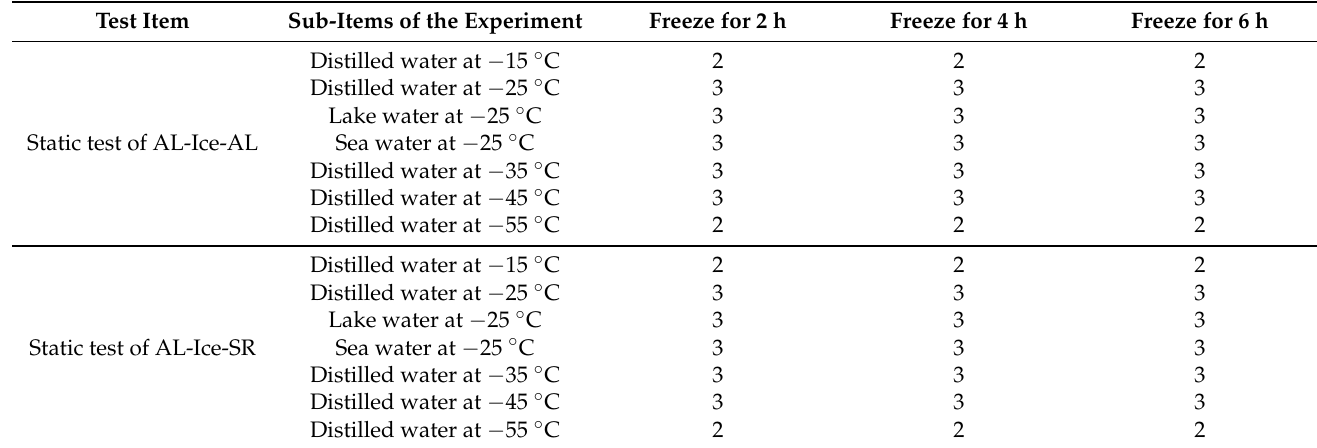
Table 3. Test the subdivision item matrix table.